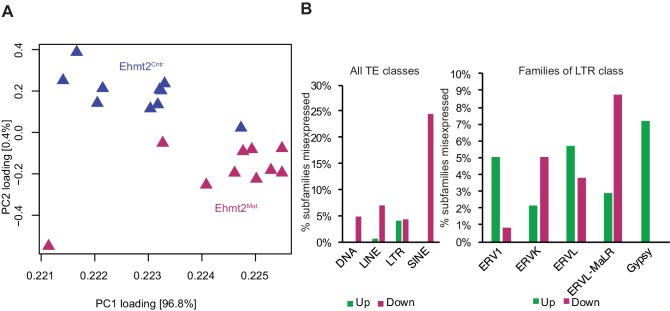
Maternal G9a is dispensable for TE repression.(A) Score plot of the first two principal components for 20 embryos using transcripts from repetitive elements. Genotype is represented by colour. (B) Bar plot showing the percentage of subfamilies upregulated (Up; green) or downregulated (Down; red) in 8C embryos upon maternal loss of G9a compared to controls. Shown are percentages within all TE classes (left panel) as well as within the LTR class (right panel). Ehmt2Cntr: control embryos with maternally inherited G9a; Ehmt2Mat embryos maternally depleted of G9a; ERV: endogenous retrovirus group; LINE: large interspersed nuclear element; LTR: long terminal repeat; MaLR: Mammalian apparent LTR retrotransposon; PC: principal component; SINE: small interspersed nuclear element; TE: transposable element.